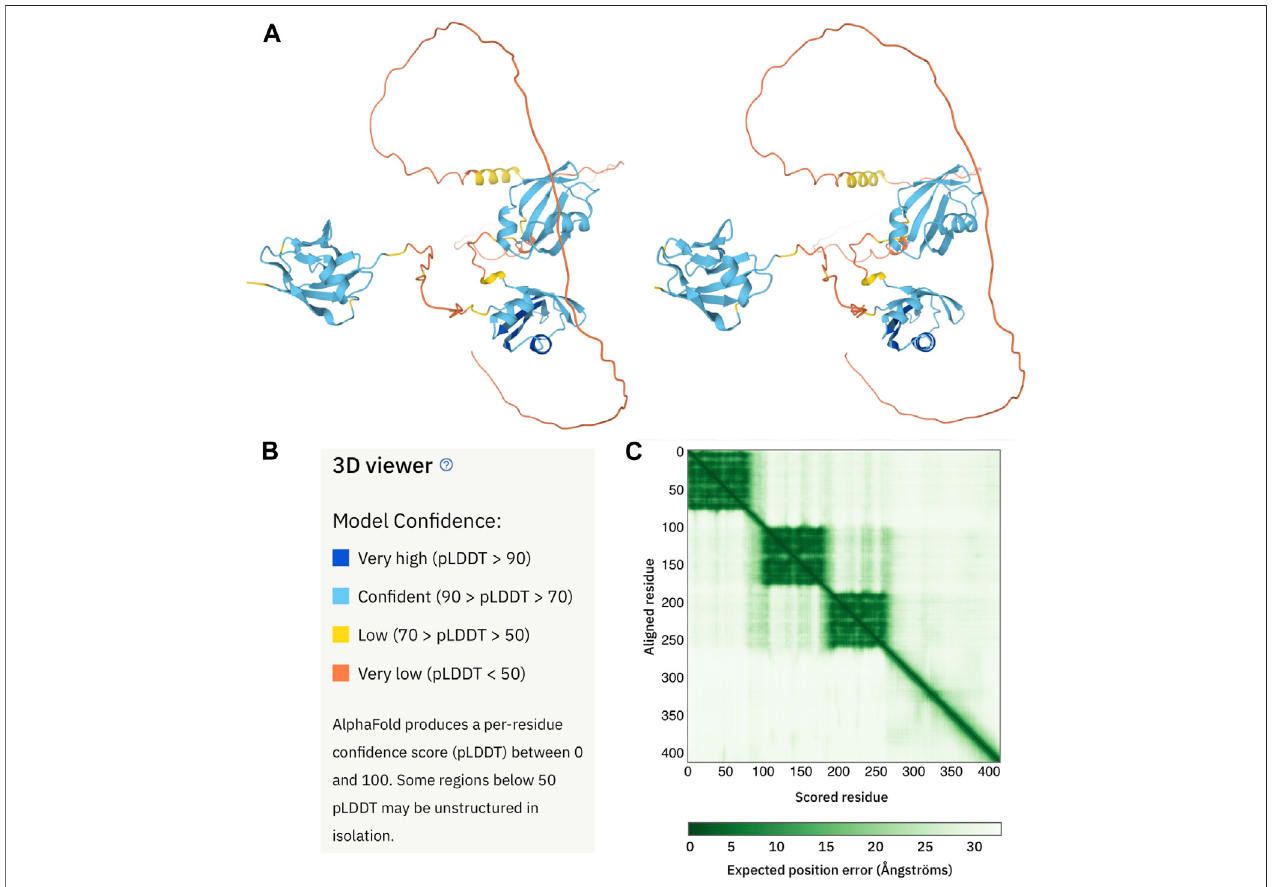
FIGURE2| AlphaFold 2structuralmodelofhumanTDP-43. (A) Cross-eyedstereo viewoftheAlphaFold 2output(https://alphafold.ebi.ac.uk/entry/Q13148)fora representative human protein, TDP-43. As de fi ned by a color code panel (B) the protein contains well folded N-terminal (appearing on the left) and two RRM domain (center) followedbyalong,poorlypredicted region.TheformerareingoodagreementwiththeirNMRsolutionstructures (Mompeán etal.,2016)(Lukavskyet al.,2013). The latter is known to be disordered but does contain a partly populated helix approximately in the position predicted with low con fi dence (yellow) by AlphaFold 2. The expected positional error panel (C) shows dark green patches for the three domains, indicating that they are well de fi ned. Note that the green shading in weak between the N-terminal domain (residues 1-80) and the RRM domains (residues 103-260). This means that their inter-domain con fi guration is not well de fi ned. By contrast, the green shading between the two RRM domains (residues 103- 175 and 195-260) is darker, indicated that their relative orientation is better de fi